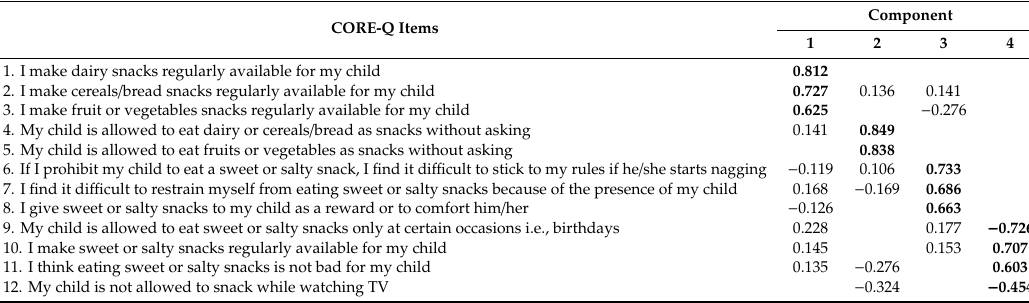
Table 1. Pattern matrix from PCA with Promax rotation a of parent / carer attitudes and practices from CORE-questionnaire (CORE-Q) item responses related to child